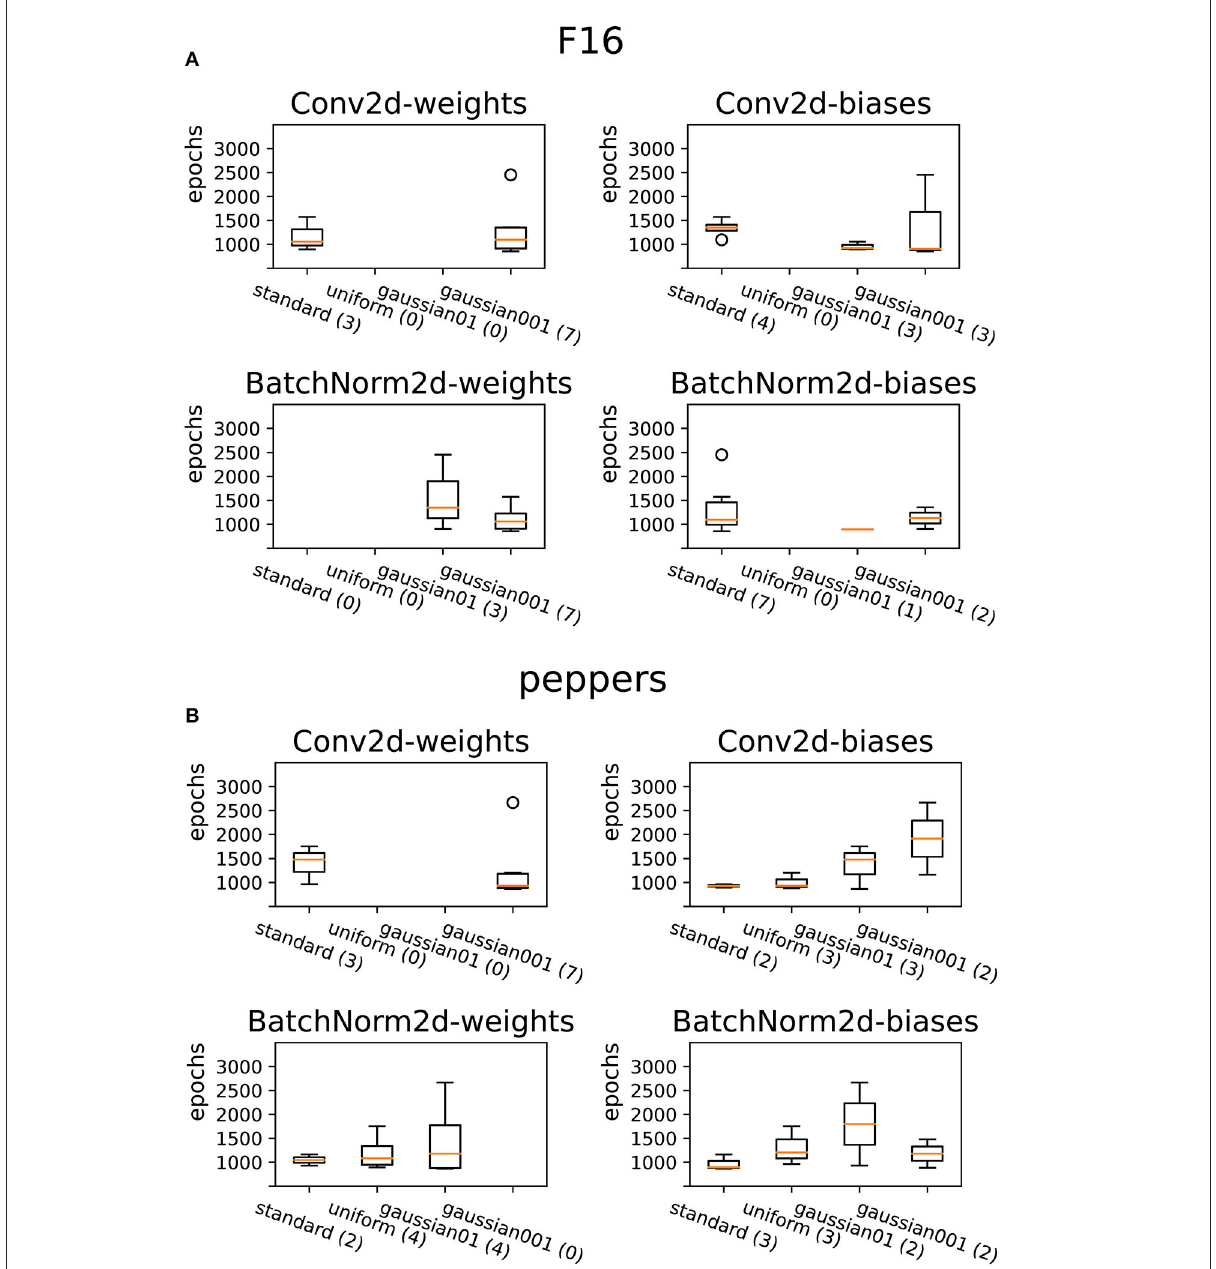
FIGURE8 Initialization with respect to the convergence speed of the first top- K experiments (with K set to 10) with higher PSNR values for the F16 image (A) and peppers image (B)